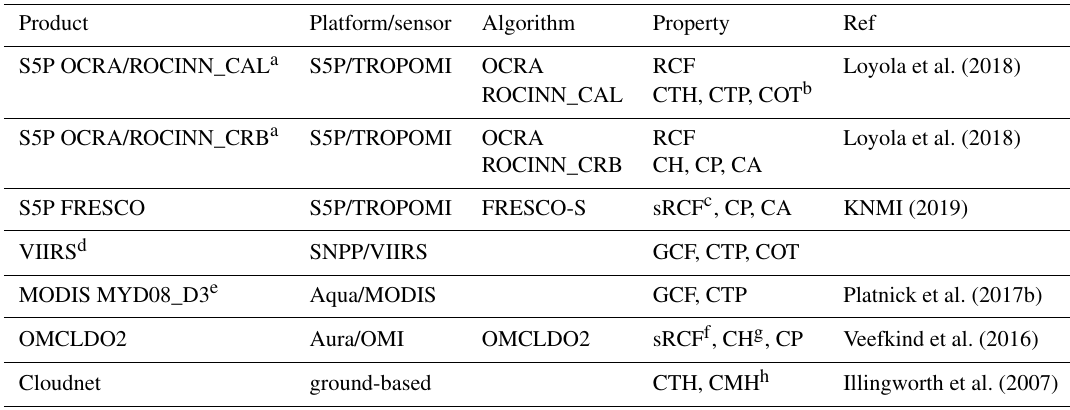
Table 2. Overview of cloud products, algorithms, and main properties discussed in this work. The property abbreviations are explained in Table